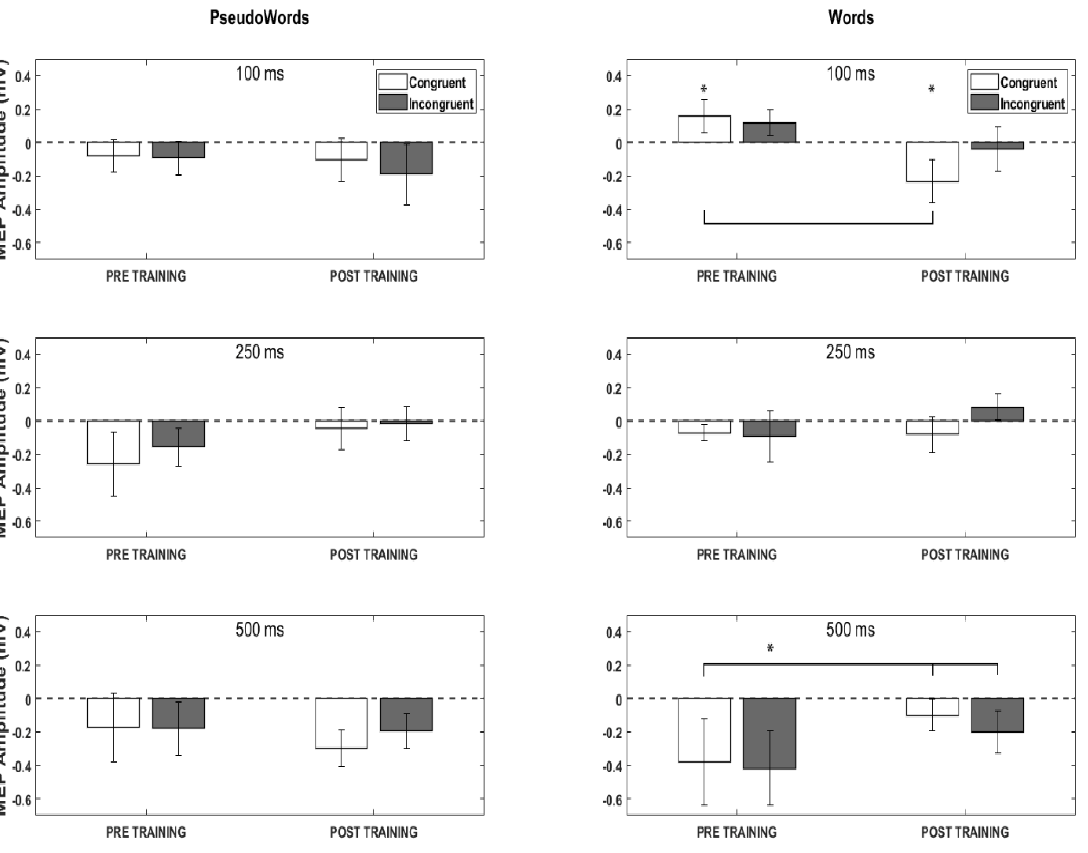
Figure 2. Averaged Motor evoked potentials (MEPs) of FDI muscle recorded after single-pulse TMS to hand primary motor cortex. Data are normalized to the baseline condition. MEPs values corresponding to T1 stimulation interval are presented in the upper row. Colored bars indicate the semantic relation between verbal stimuli and gestures. White bars represented data from congruent verbal stimuli, while black bars represented data from incongruent verbal stimuli. The middle and lower rows depict MEPs data corresponding to T2 and T3 stimulation intervals, respectively. Vertical and horizontal bars represent Standard Errors and significance in the statistical comparisons. Asterisks indicate significant t -test against zero (baseline